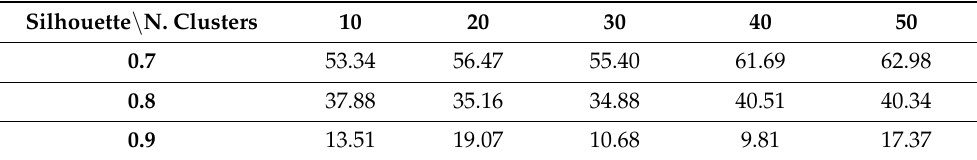
Table 12. Clustering performance in terms of silhouettes using the reduced dataset with SPQR applied to normalized data.